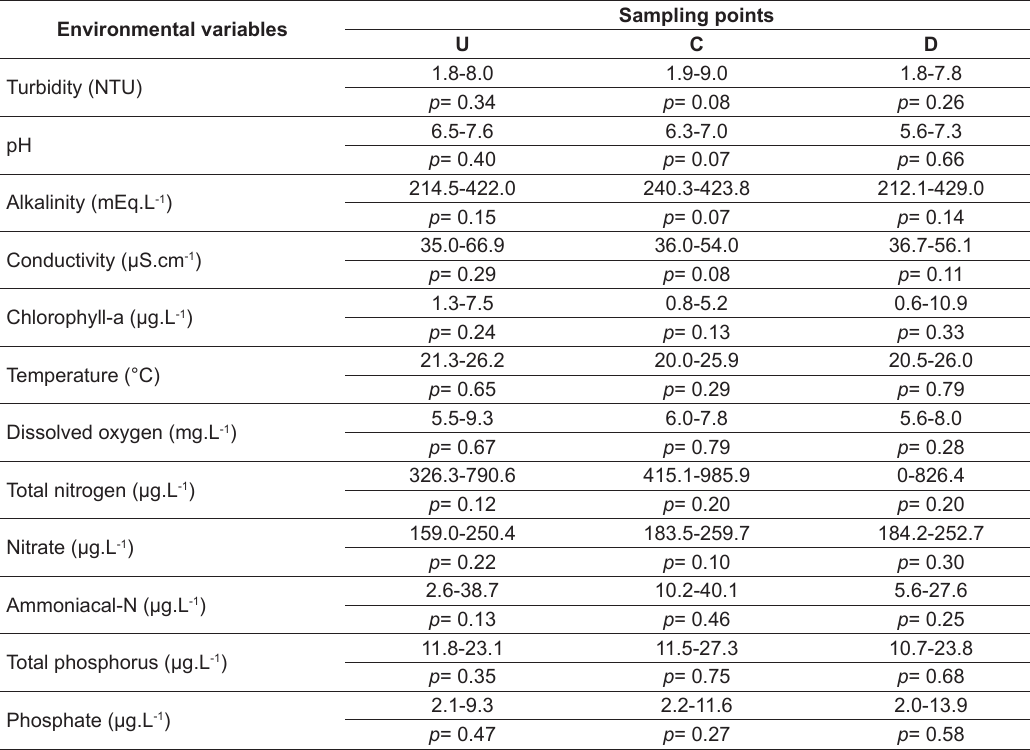
Table 3. Minimum, maximum values and significance of the environmental variables recorded for each studied points (U = upstream; C = cage installation location; D = downstream) - Corvo River, Rosana reservoir (SP/PR).